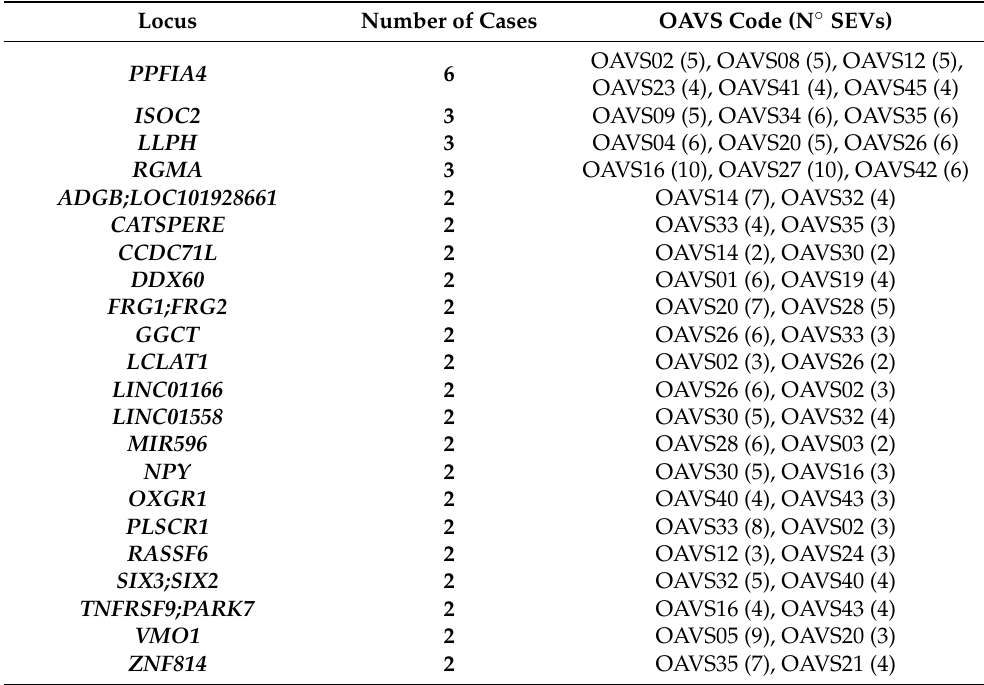
Table 2. Most shared hyper-methylated genes.